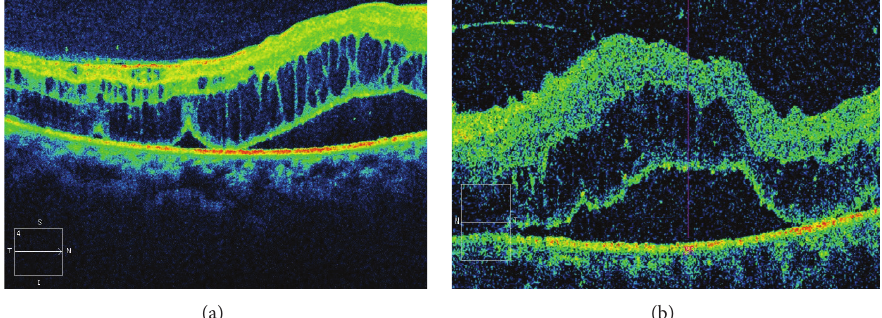
Figure 2: Optical coherence tomography: (a) the right eye; (b) the left eye.